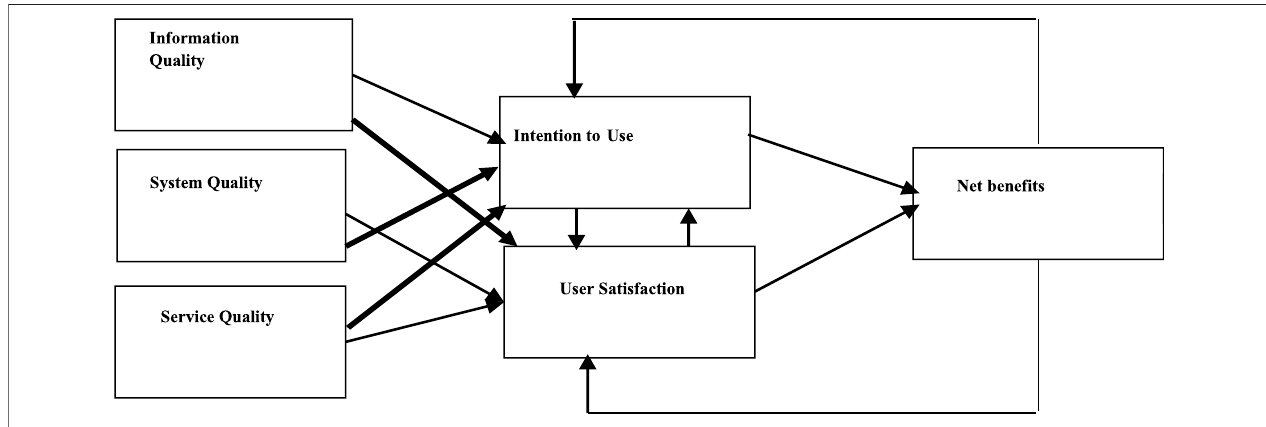
FIGURE 1 | Updated DeLone and McLean IS success model (D&MISSM). Source: DeLone and McLean